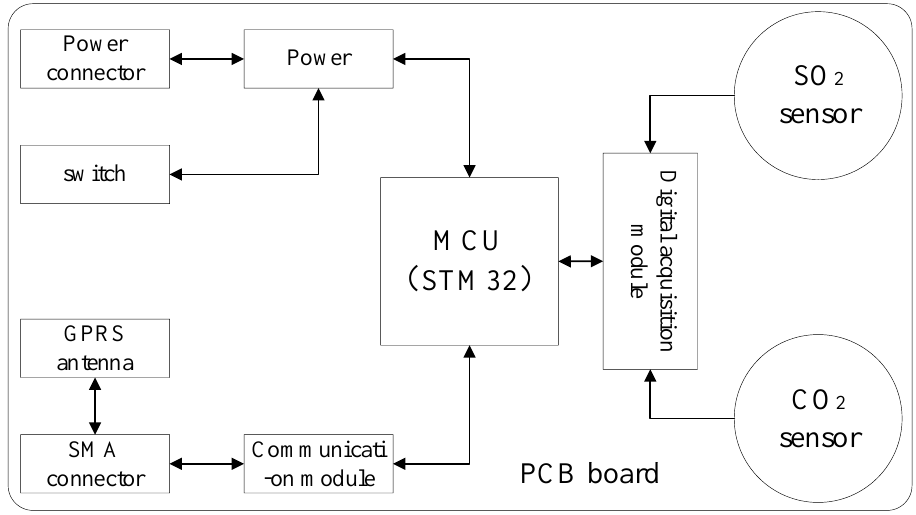
Figure 3. The structure diagram of the diffused mini-sniffing sensor.